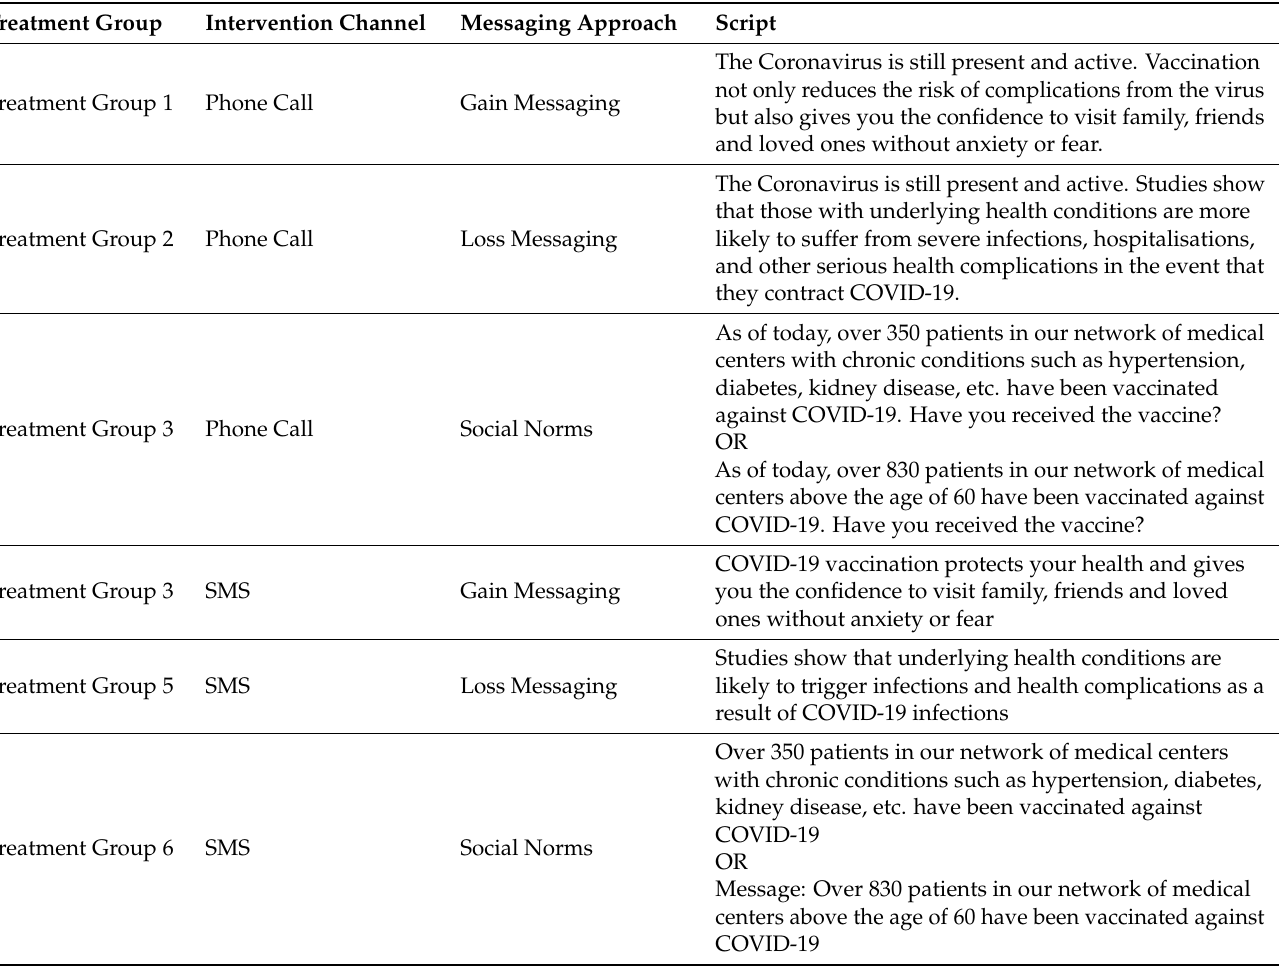
Table 1. Summary of intervention provided by each treatment